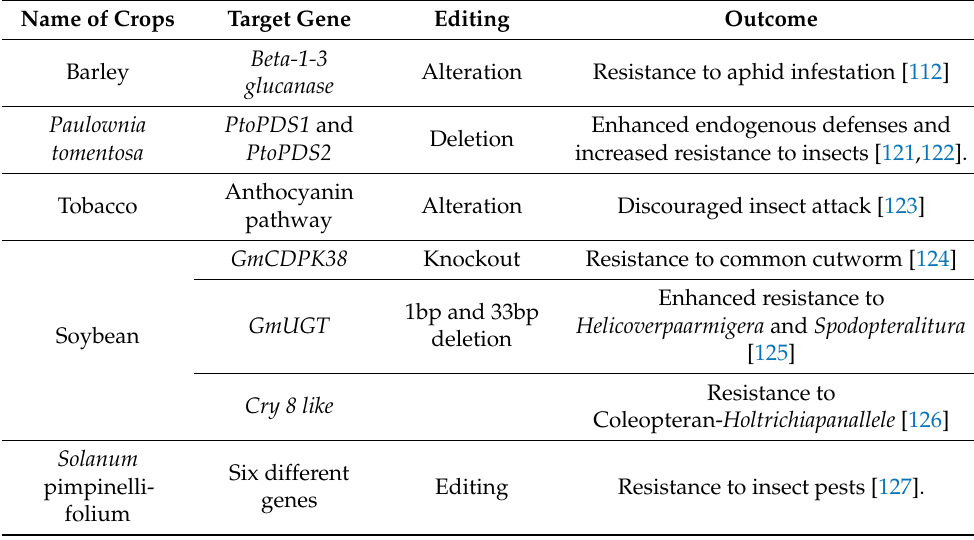
Table 2. CRISPR-Cas genome editing in crops for insect pest